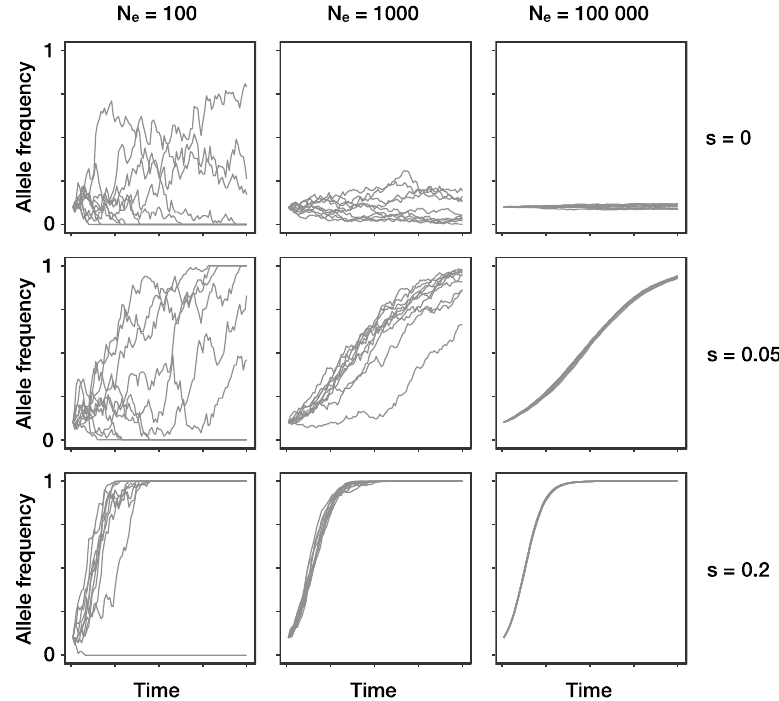
Figure 1. The combined effects of drift and selection on genetic change over time ( x -axis). Shown are simulated allele frequencies ( y -axis) of a focal allele for different combinations of effective population size N e (columns) and selection coefficient s (rows). A positive selection coefficient ( s > 0) indicates a selective advantage of the focal allele compared to the other allele, if s = 0 both alleles are neutral and thus, allele frequency changes are only due to genetic drift. Each panel shows the results of ten independent replicates with an initial frequency of 0.1 for the focal allele. Note that when effective population size is small, even positively selected alleles sometimes go extinct due to drift (left column, middle and bottom row). Absolute frequencies k of the allele in generation t + 1 were obtained by randomly drawing from a binomial distribution with P ( X = k ) = (cid:3439)(cid:1868) (cid:3047)(cid:2878)(cid:2869)(cid:3038) (1 − (cid:1868) (cid:3047)(cid:2878)(cid:2869) ) (cid:3041)(cid:2879)(cid:3038) and p t + 1 = p t ( 1 + s ) , where w denotes the average fitness of the population and p t+1 denotes the expected frequency of the focal allele without drift in the next generation t +1.